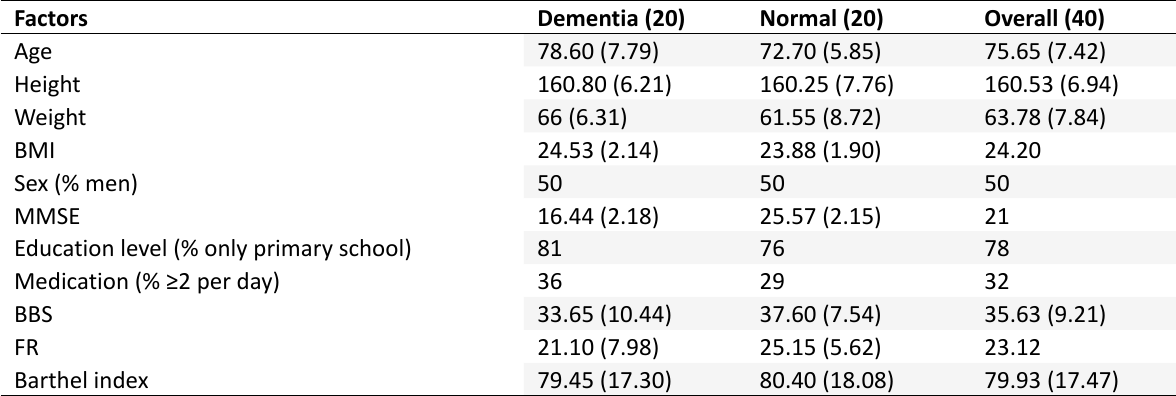
Table 1. Baseline characteristics of participants